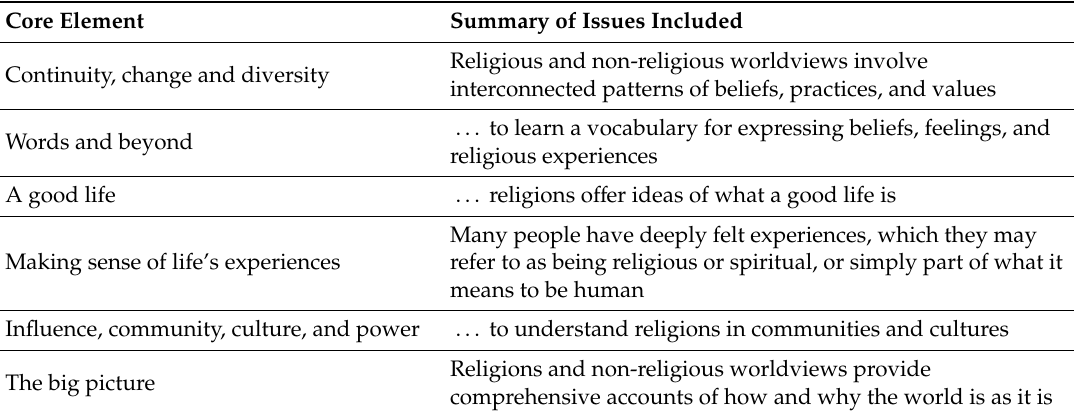
Table 2. Core elements in Wintersgill (2015).